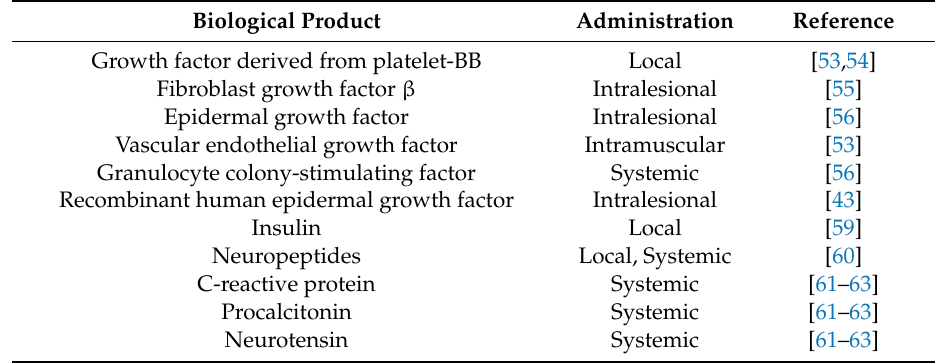
Table 4. Biological products that work in wound repairing for the treatment of DFUs: growth factors and other non-growth factor